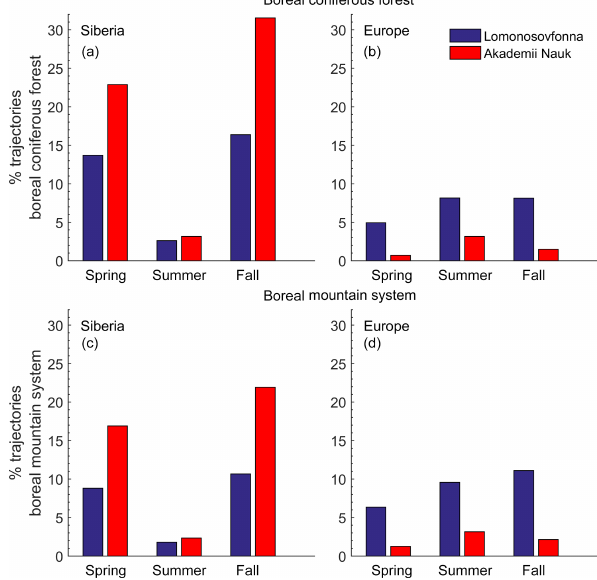
Figure 7. Ten-day back trajectories from 2006 to 2015 reach- ing the boreal ecosystems starting from the Lomonosovfonna and Akademii Nauk ice core locations. Blue is Lomonosovfonna and red is Akademii Nauk. Trajectories reaching: Siberia (a, c) , Eu- rope (b, d) , boreal coniferous forest (a, b) , and boreal mountain system (c, d)